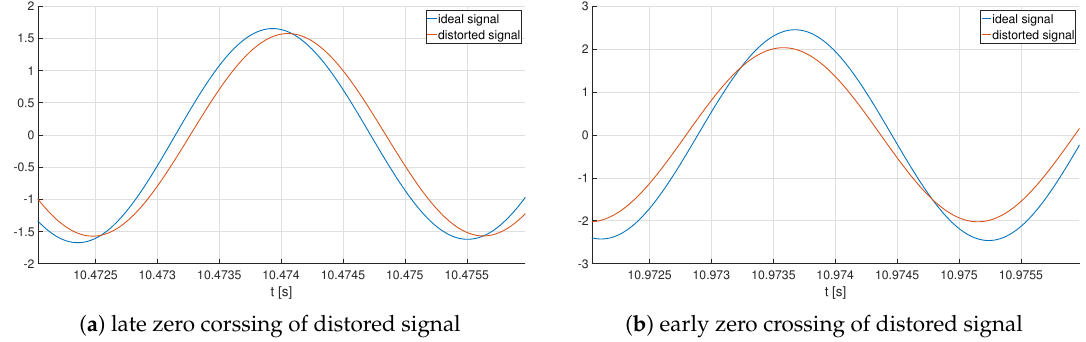
Figure 3. Ideal and distorted sensing signal y ( t ) with 0.5 ◦ phase and 5% amplitude